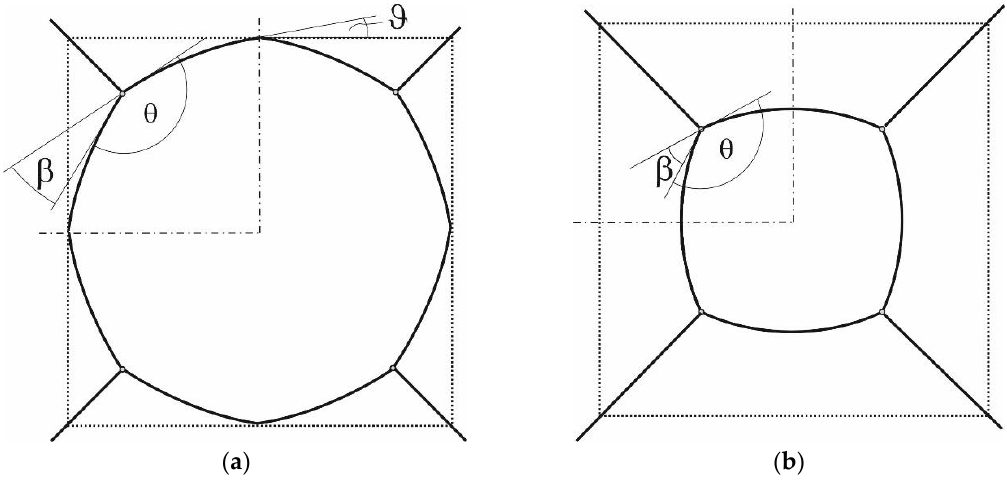
Figure 5. Shrinking of the initially quadratic grain: ( a ) Case I: The centers of the grain boundaries are fixed; thus, an edge formation with angle ϑ can occur at this center. ( b ) Case II: The centers of the grain boundaries can move due to symmetric boundary conditions and the initially quadratic grain shrinks and eventually disappears.